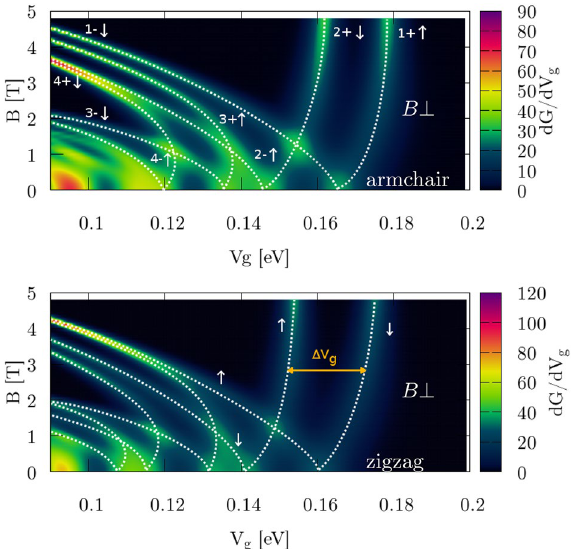
Figure 7. ( a ) Transconductance for the perpendicular B Two first (1, 2) subbands are marked in K ′ (+) and K (−) valley with spin up ( transconductance peaks correspond to new conductive states in the paired spin-subbands which are close enough not to be seen as separate peak [see zoom in plot ( b )]. Results are for zigzag edges.